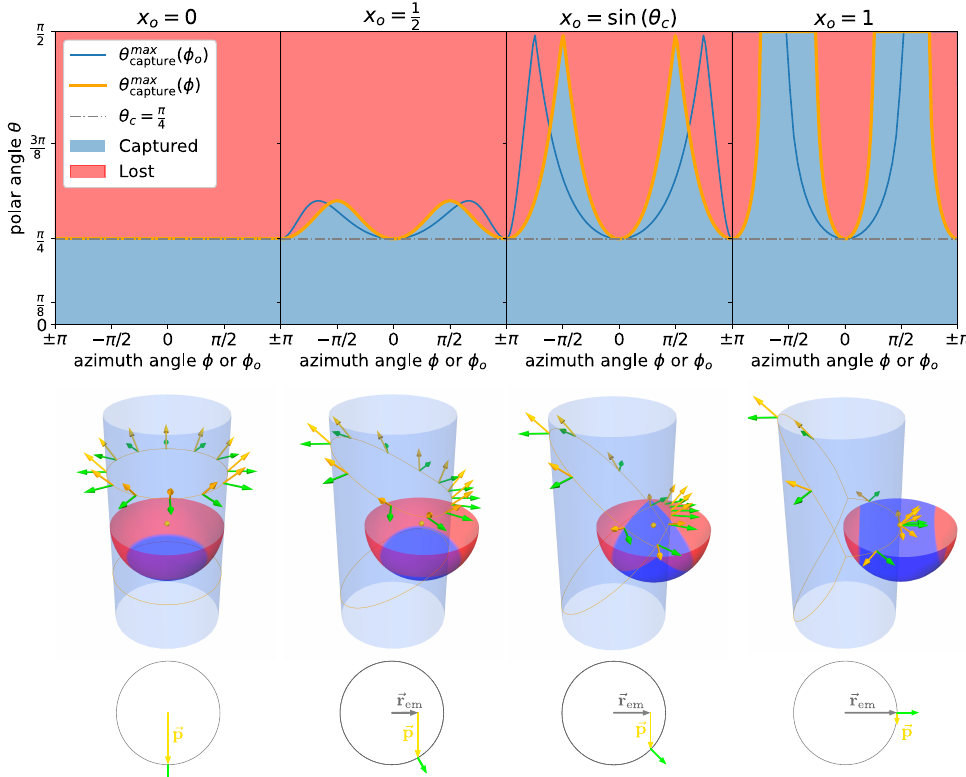
Figure 3. Illustration of the solid angle under which the photons are captured as a function of the relative fraction of the radius x 0 = | (cid:126) r | / R at which the photons are emitted (indicated by the yellow dot). The orange (blue) line in the upper plot indicates photons that encounter the surface under the critical angle as a function of the azimuth angle φ ( φ 0 ) relative to the emission point (center of the cylinder). In the upper and middle plots, the blue shaded areas indicate solid angle regions under which photon trajectories are captured by total internal reflection, while red shaded areas show those that are not captured. In the middle plot, yellow arrows indicate directions of incident photons, while green arrows depict surface normals. In this example, the critical angle is chosen as θ c = π